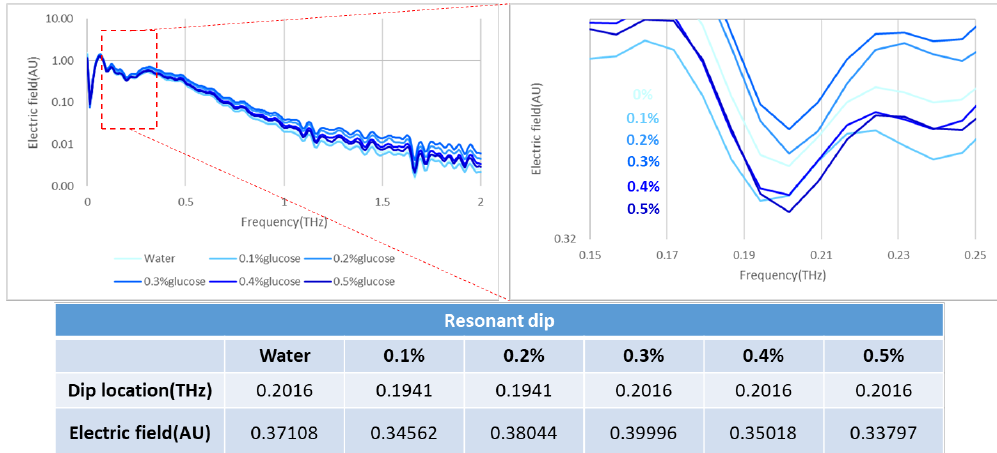
Figure 7. Trial of measurement of glucose aqueous solution from 0% to 0.5% with no tendency of variation.